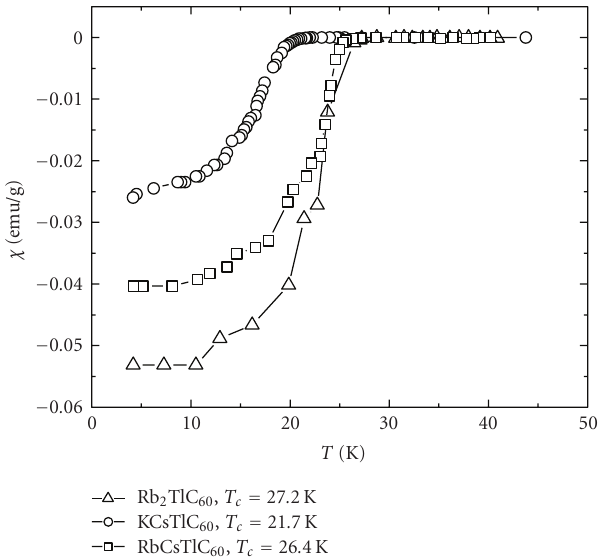
Figure 1: Temperature dependencies of magnetic susceptibility of